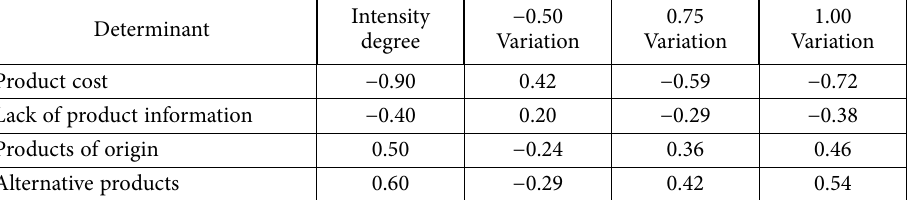
Table 9. Analysis of